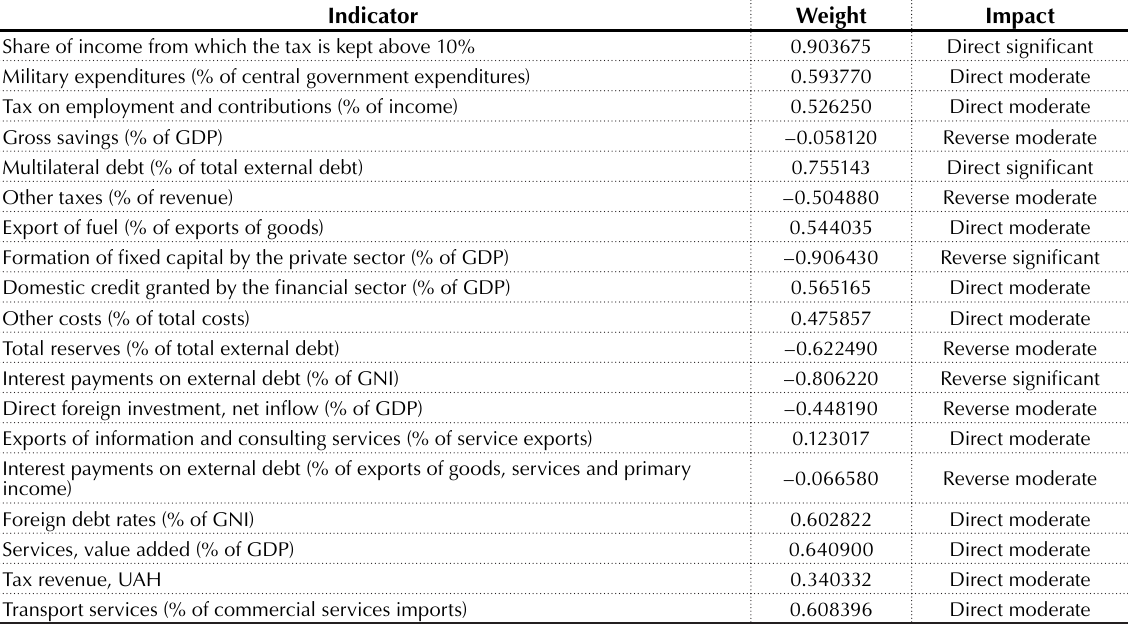
Table 1. Influence of separate indicators of the national economy on the money supply of the